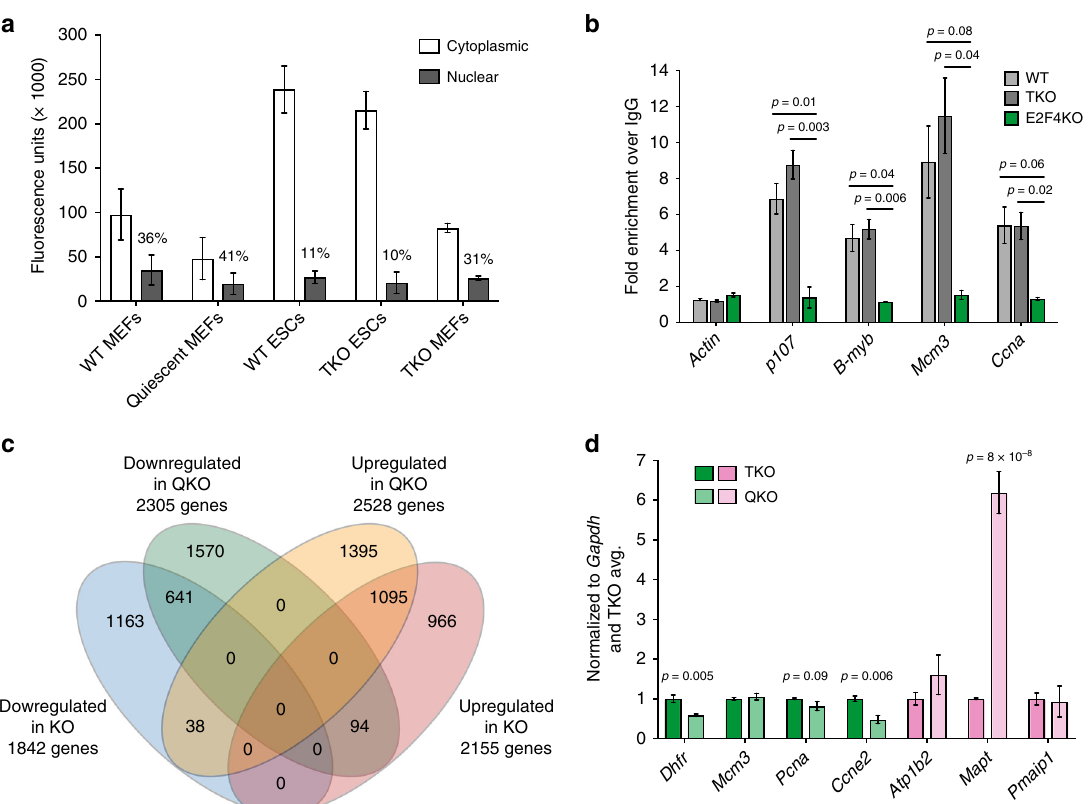
Fig. 6 E2F4 can access chromatin and regulate target genes in an RB family-independent manner. a Quanti fi cation of cytoplasmic and nuclear E2F4 expression by immunoassay in cycling and quiescent mouse embryonic fi broblasts (MEFs), WT and TKO mouse ES cells, and TKO MEFs ( n = 2 – 3 biological replicates per cell type). The percentage of nuclear E2F4 is shown. See Supplementary Fig. 9 for fractionation controls. b Quanti fi cation of E2F4 binding to target genes and an Actin negative control in WT, TKO, and E2F4KO mouse ES cells, assayed by ChIP-qPCR (unpaired t -test was performed with all individual data points from n = 2 – 3 biological replicates of 2 WT, 2 TKO, and 1 E2F4KO clone(s)). Binding was normalized to 10% input and then to binding of an IgG control. c Overlap of genes that are differentially expressed in QKO versus TKO mouse ES cells, and genes that are differentially expressed in E2F4KO (KO) versus wild-type (WT) mouse ES cells ( q -value < 0.05 with a fold change > 0.5 (log2)). The sets of upregulated (1095) and downregulated (641) genes between E2F4KO/WT and QKO/TKO mouse ES cells are highly similar ( p -value close to zero). d RT-qPCR validation of differentially expressed genes. Expression of downregulated genes in TKO (dark green) and QKO mouse ES cells (light green); and upregulated genes in TKO (pink) and QKO mouse ES cells (light pink), was normalized to Gapdh expression and then to expression levels in TKO cells (unpaired t -test was performed with all individual data points from n = 2 – 4 biological replicates with 2 TKO and 2 QKO clones). Data shown as the mean and standard error